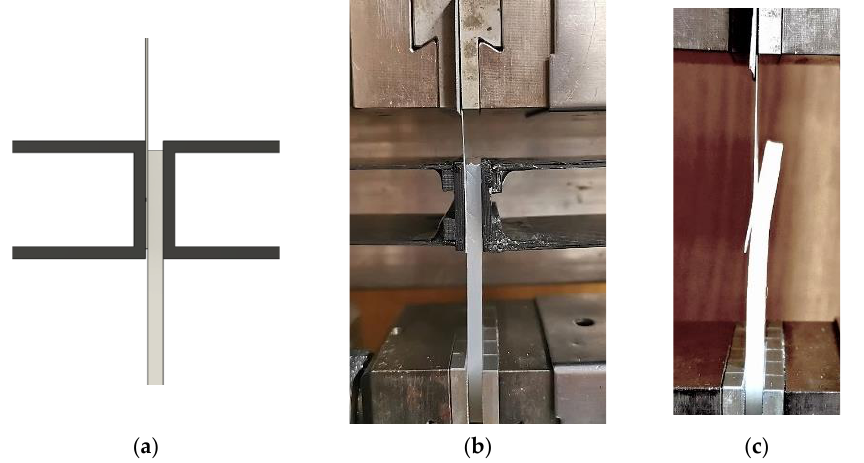
Figure 4. 3D modeled tensile test ( a ); tensile test with clamp ( b ); tensile test without clamp ( c ).